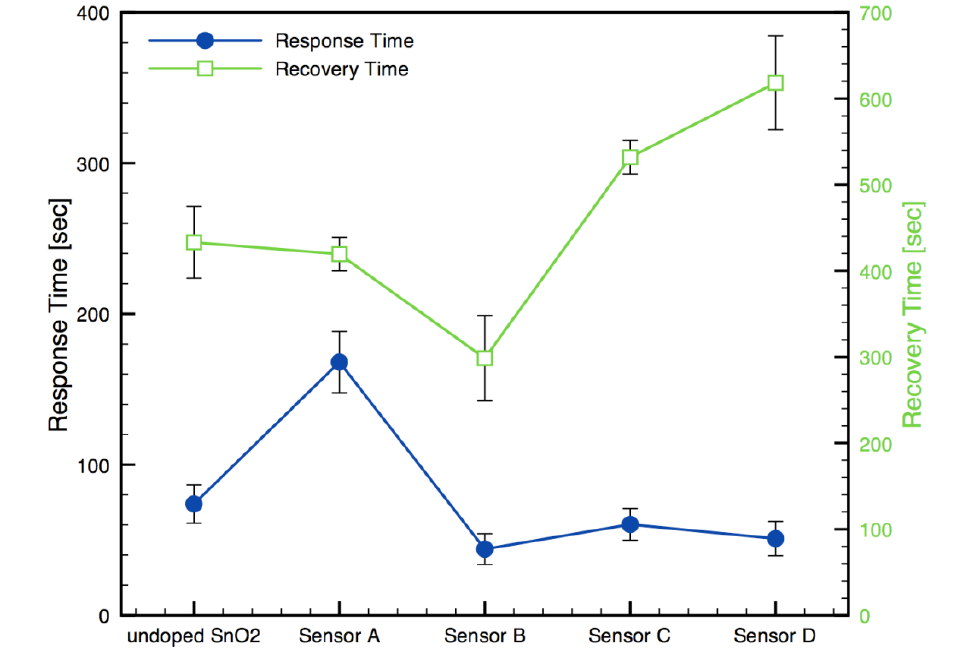
Figure 10. Comparison of the response and recovery times for the sensor